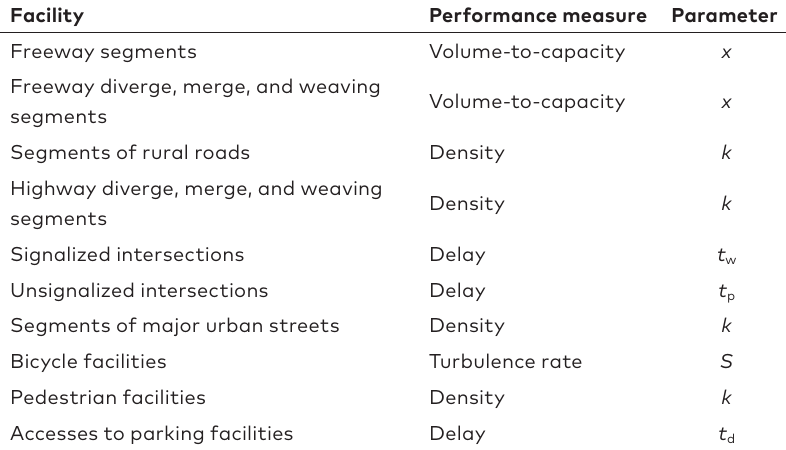
Table 2. Performance measures to determine LOS in the HBS (FGSV, 2015)